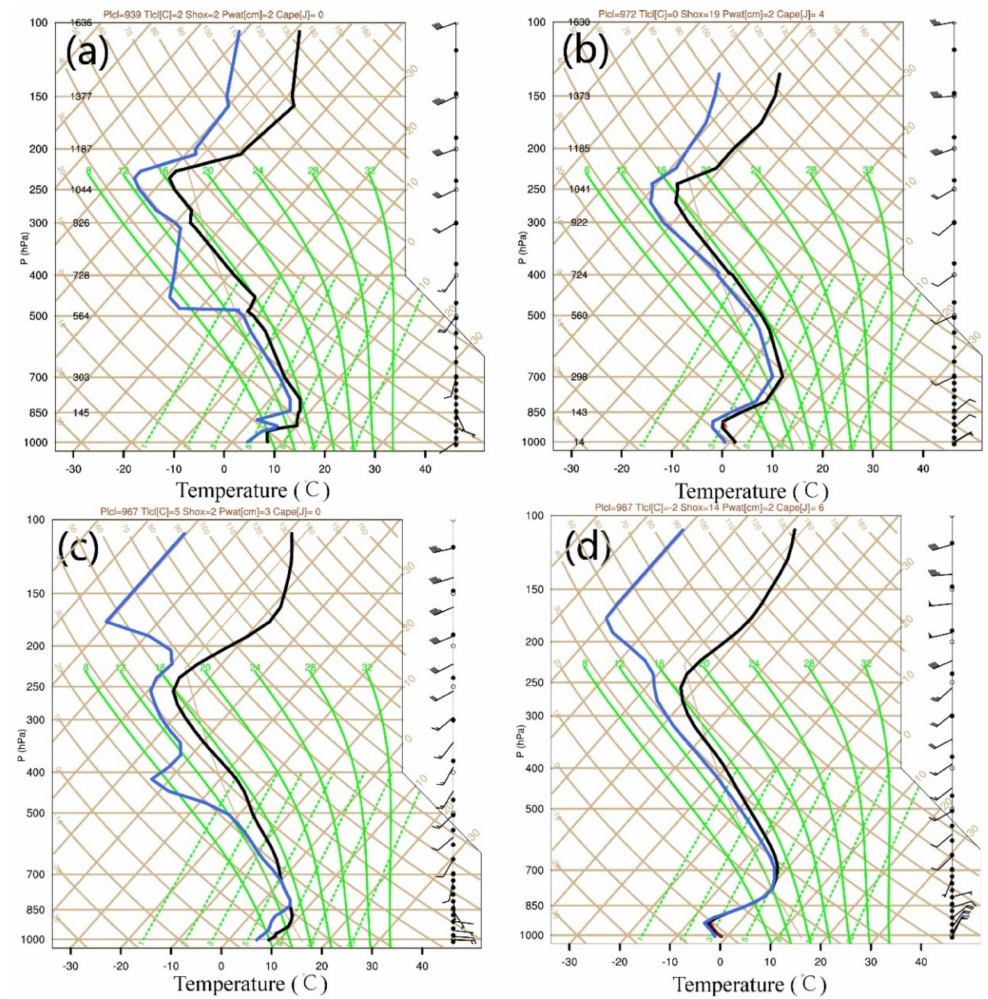
Figure 8. Skew T-logp diagrams at Zhangqiu sounding station from ( a , b ) observation and ( c , d ) the WRF run at ( a , c ) 1200 UTC on 12 February and ( b , d ) 0000 UTC on 13